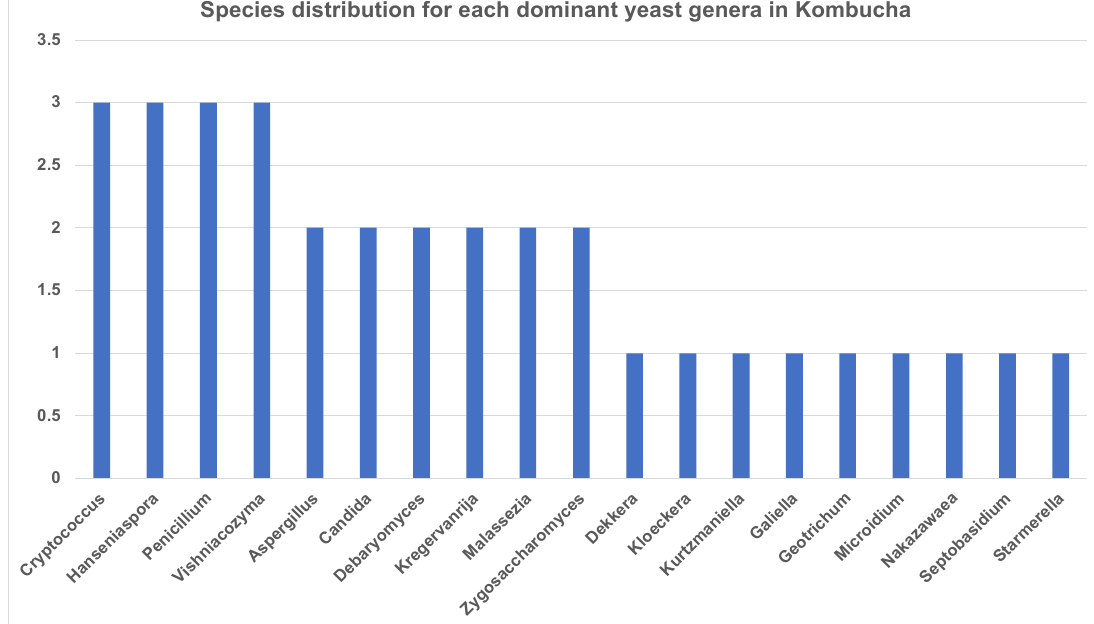
Figure 5. Abundance of yeast species each dominant genus has in kombucha. On average, genus Cryptococcus , Hanseniaspora , Penicillium and Vishniacozyma show three different species across kombucha samples.